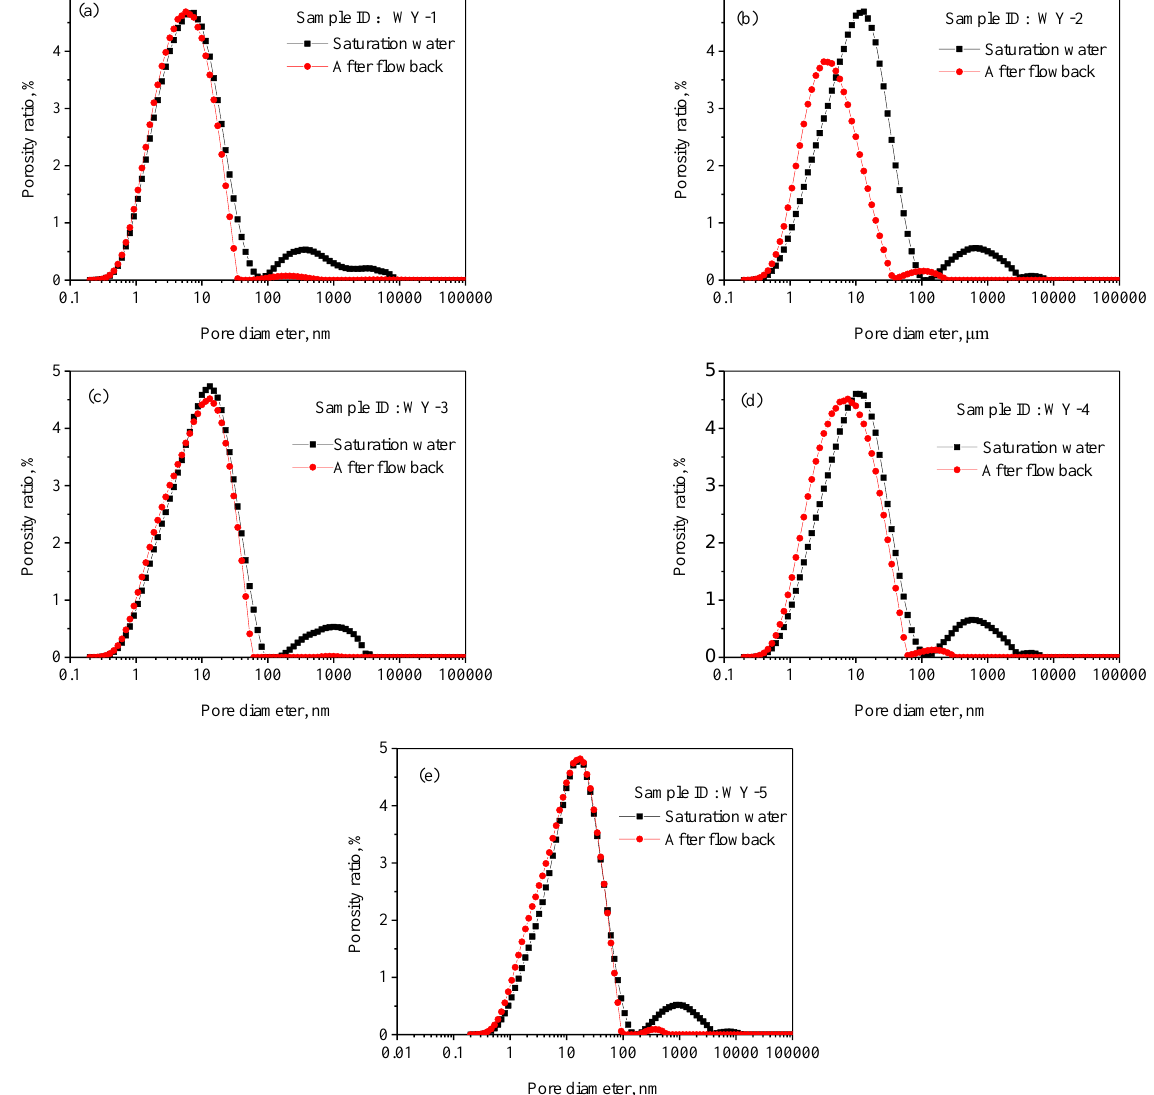
Figure 9. Distribution of distilled water in multiscale pore spaces of five shale samples after saturated water and water flow back (The content of water phase larger than 100nm pore diameter decreased obviously, while in pores smaller than 100 nm did not change obviously). There is still a large amount of water in the pore spaces with D < 100 nm after the flowback of five shale samples, but there is relatively little of the water phase in the pore spaces with D > 100 nm (Figure 10). The content of retained water in five shale samples after flowback ranges from 9.68% to 16.97%. It is worth noting that the retained water content in shale samples does not decrease with the increase of flowback pressure differ- ence (Table 4). This shows that when the pressure gradient is in the range of 0.06~0.18 MPa/cm, the retention of the water phase does not decrease with the increase in the pres- sure gradient of flowback. After the dominant gas channel is formed in the process of